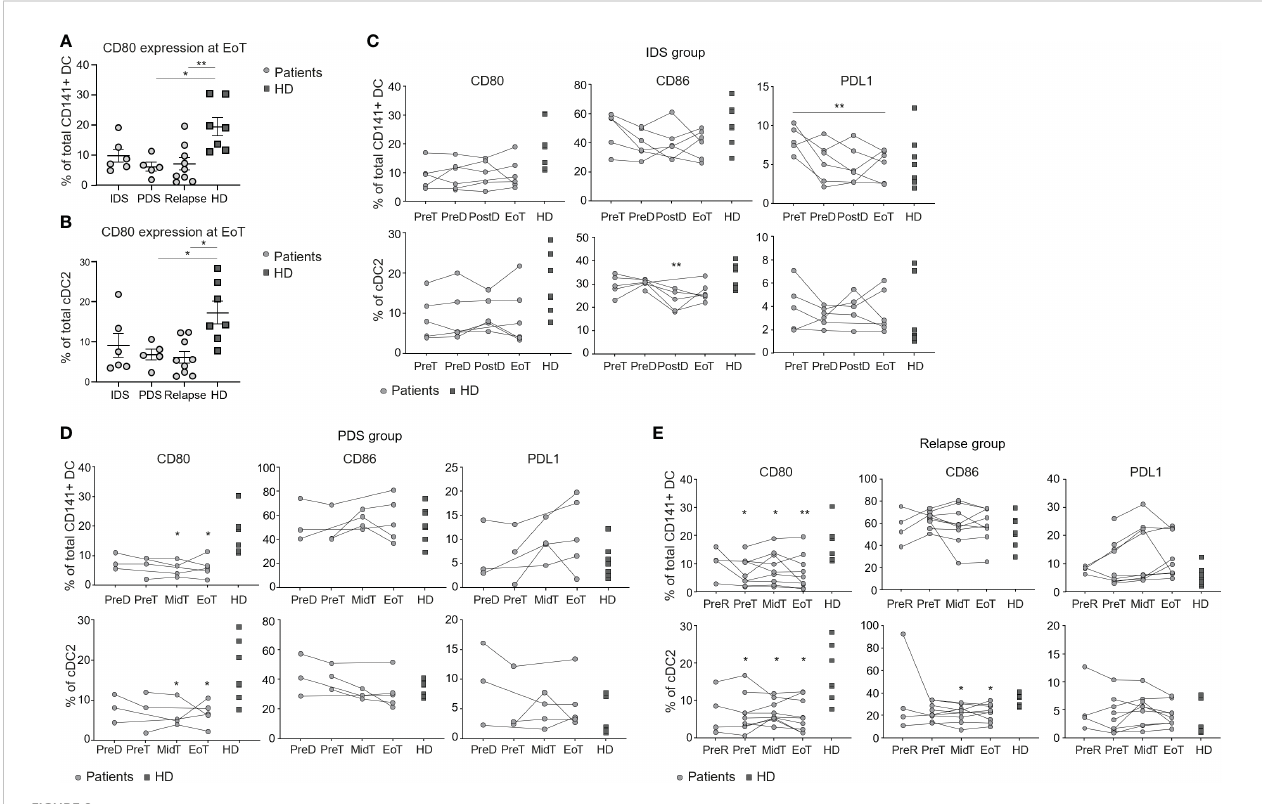
FIGURE 2 Longitudinal monitoring of the activation pro fi le of DC populations in patients with OvC and HD. Cumulative data of the CD80 expression levels in total CD141 + DCs (A) and in cDC2 (B) measured in patients with OvC at the end of treatment and in HD. Cumulative data of the CD80, CD86 and PDL1 expression levels in total CD141 + DCs and in cDC2. Measurements were performed in patients with OvC (grey dots) at recruitment, during treatment and at EoT, belonging to (C) IDS group, (D) PDS group, or (E) relapse group and are compared to HD (dark grey squares). In the relapse group, analyses have also been performed at a time-point before time of relapse (PreR). * p < 0.05, ** p < 0.01. One-way ANOVA tests followed by pairwise Dunn ’ s